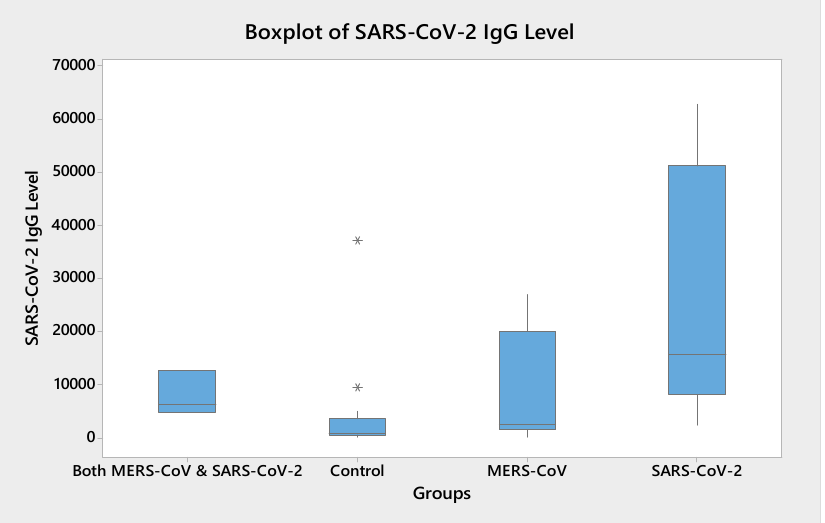
Figure 1. SARS-CoV-2 Serology as Boxplot.